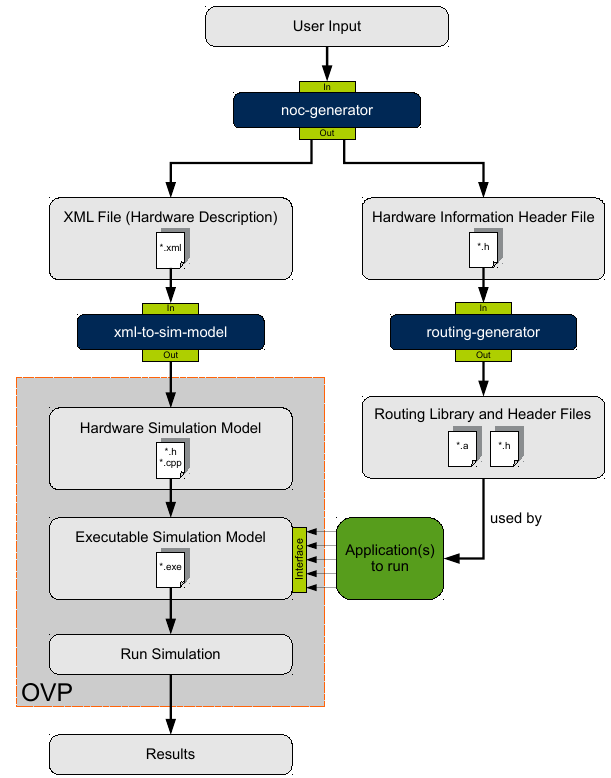
Figure 2: Overview of the tools and components of the framework